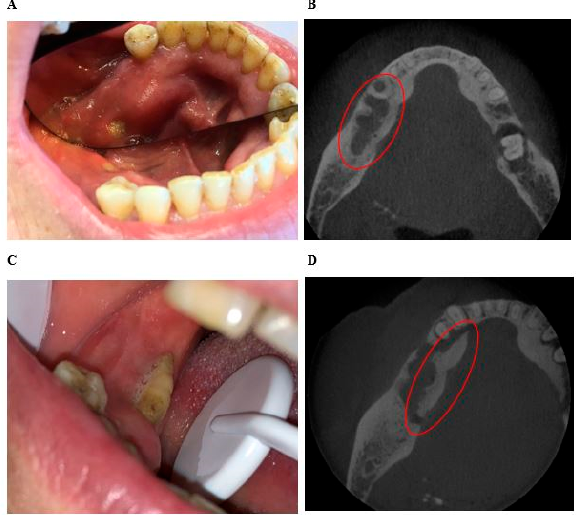
Figure 5. Example of the difference between the clinical extent and radiographic extent of osteonecrosis determined with CBCT in the same patient 7 months apart. ( A ) Mrs C: Intraoral view showing small bone exposure of 3 mm of the inner mandibular cortical of the mandible. ( B ) Mrs C: CBCT image of axial section of the mandible, showing bone osteolysis and abnormalities from the premolar region to the first molar region of the right mandible. The radiological extent is more important than the clinical extent. ( C ) Mrs C: Intraoral view 7 months later showing bone exposure of 8 mm of the crestal and inner cortical of the right mandible ( D ) Mrs C: CBCT image of axial section of mandible 7 months later showing a mandibular sequestration extended from the canine to the first right molar. The radiological extent is more important than the clinical extent.